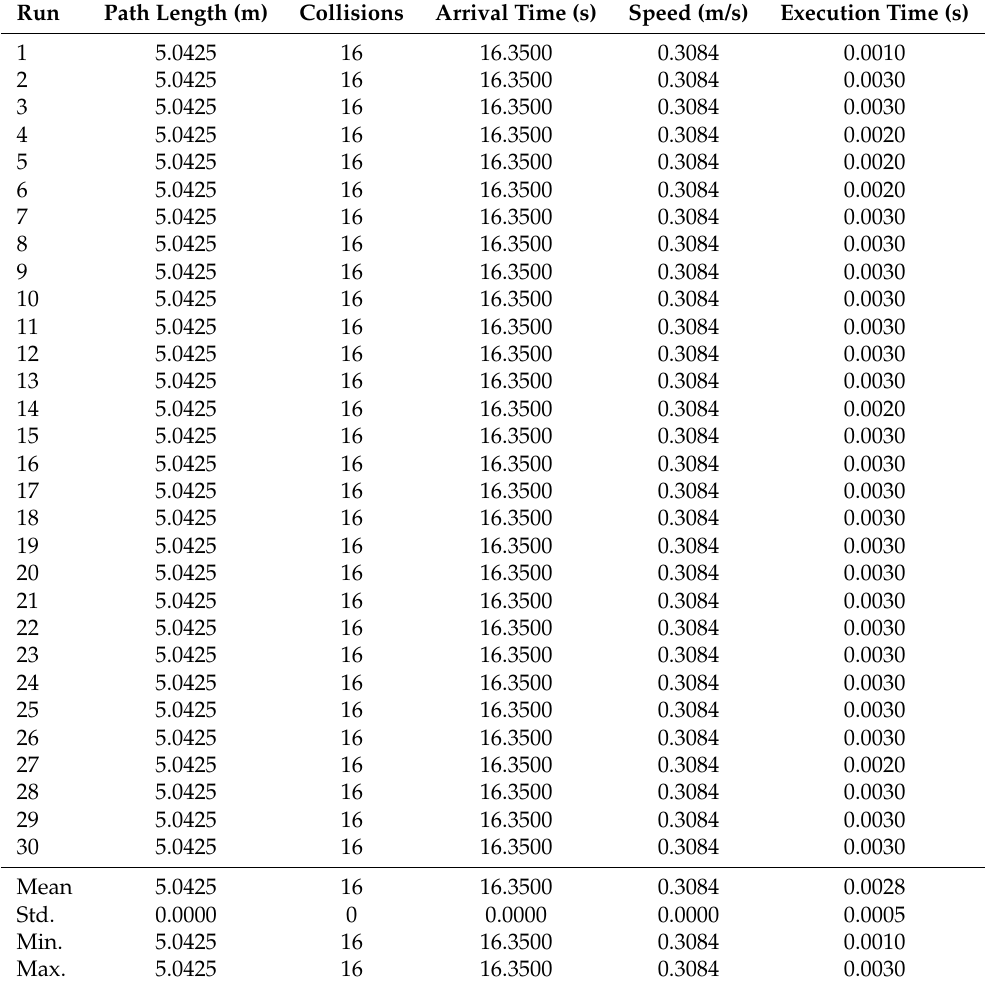
Table 7. Results of Bug0 + after 30 independent